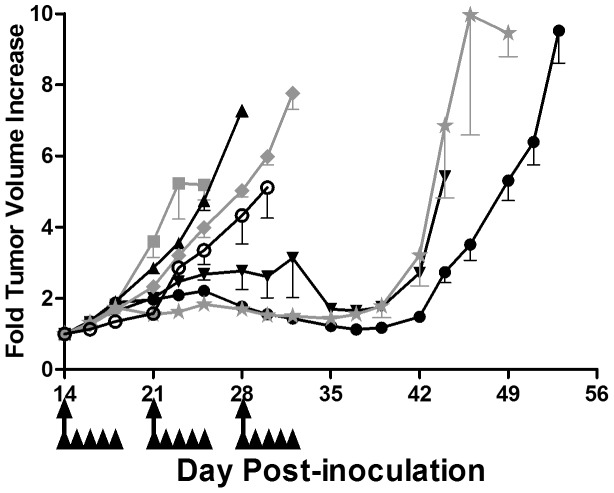
Efficacy of IRI/5-FU and IrC™/5-FU treatment in the HT-29 s.c. model of CRC.Mice bearing s.c. HT-29 tumors were treated with saline+D5W (grey solid square), 5-FU (16 mg/kg; black solid upright triangle), IRI (60 mg/kg; grey solid diamond), IrC™ (40 or 60 mg IRI/kg; black solid inverted triangle or black solid circle, respectively), IRI +5-FU (60 mg/kg +16 mg/kg; black open circle), or IrC™ +5-FU (40 mg IRI/kg +16 mg/kg; grey solid star). Beginning on day 14, D5W and 5-FU were administered QD×5 (x 3 weeks) via i.p. injection (arrowheads); all other treatments were administered Q7D×3 via i.v. injection (full arrows). Data are presented as mean fold tumor volume increase +/− standard error of the mean (n = 6).